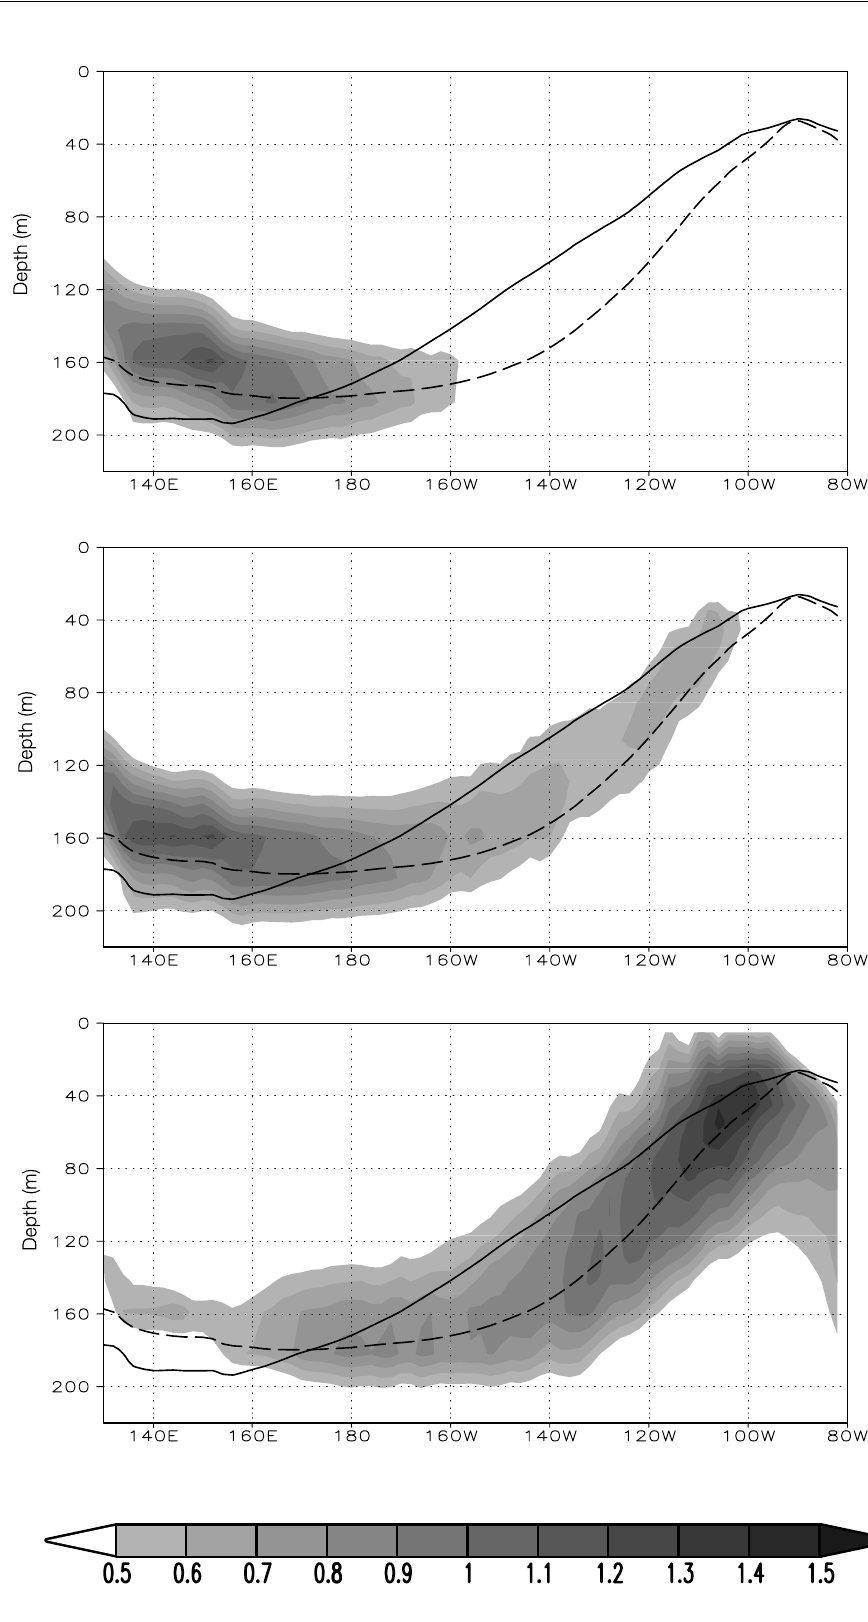
Fig. 4. Vertical section of temperature anomalies ( ° C) along the equatorial Pacific for warm events of type II in months –13 ( top ), – 11 ( middle ) and – 9 ( bottom ). Superimposed are the climatological 20 ° C isotherm in January (broken line) and March (solid